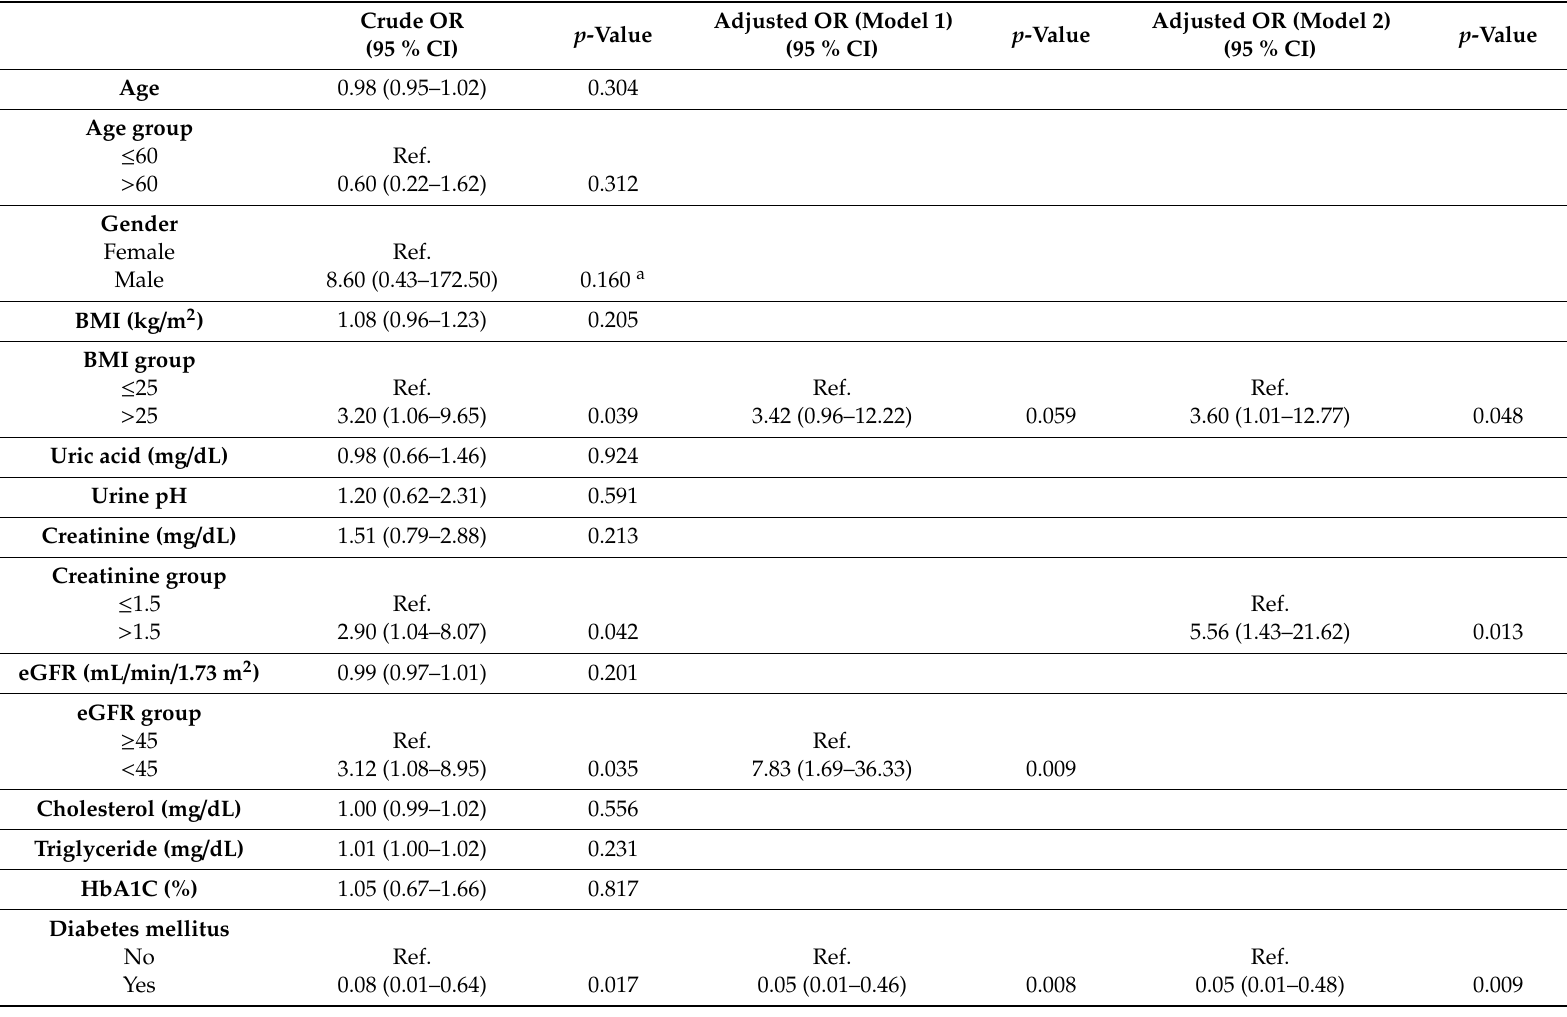
Table 4. Logistic regression analysis of risk factors for gout among predominant uric acid urolithiasis patients (uric acid >